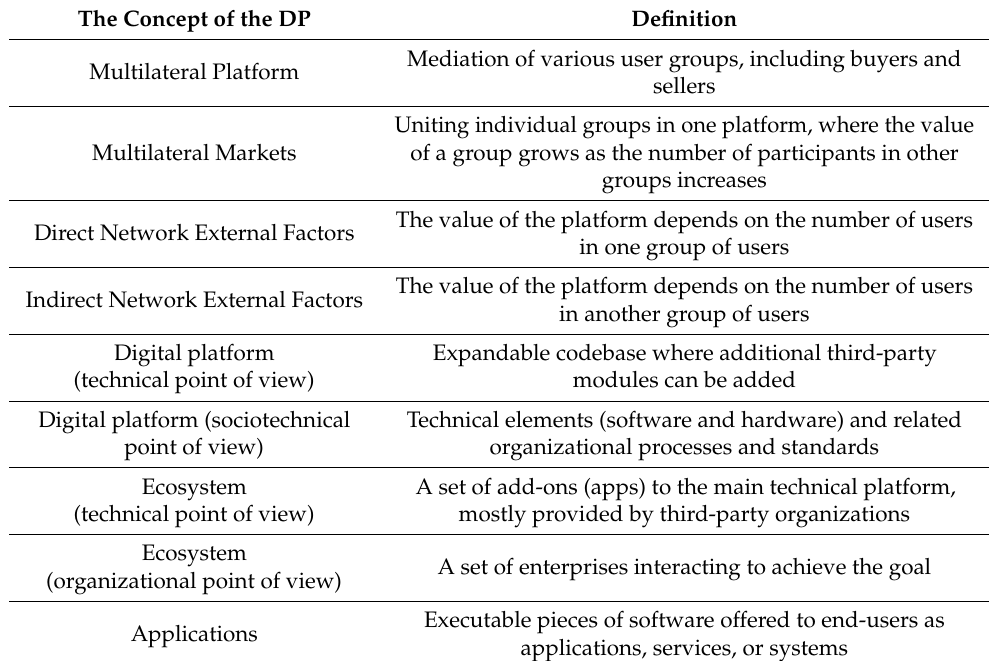
Table 1. Different definitions of the concept of the “digital platform“ (DP)